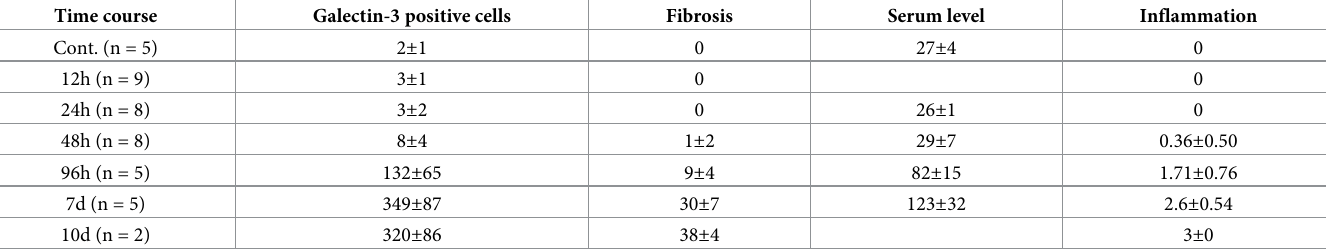
Cell numbers of immunoreactive galectin-3 in cardiac tissue were counted (as cell numbers/mm 2 ). The degree of myocardial fibrosis was quantified as percentage of fibrotic area to total myocardial tissue in each time-course of Azan staining. The serum level of galectin-3 were measured by ELISA (ng/mL). Inflammation response score was evaluated grade 0 to